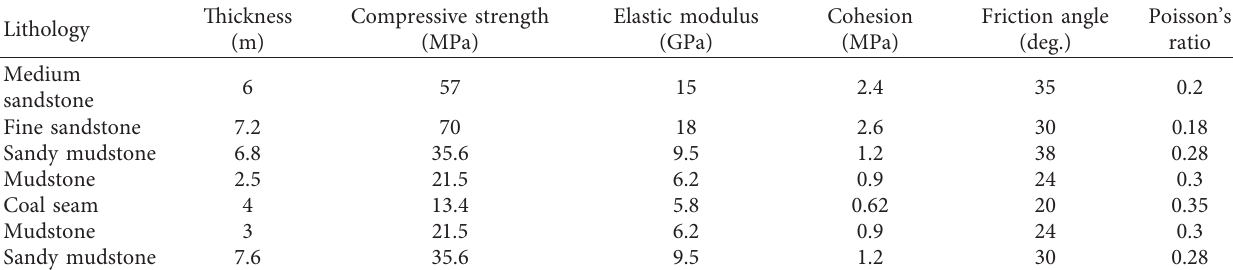
Table 1: Physical and mechanical parameters of coal and rock.